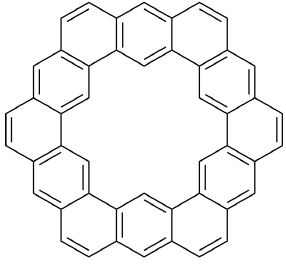
Figure 13. Molecular structure of circumcoronene with a